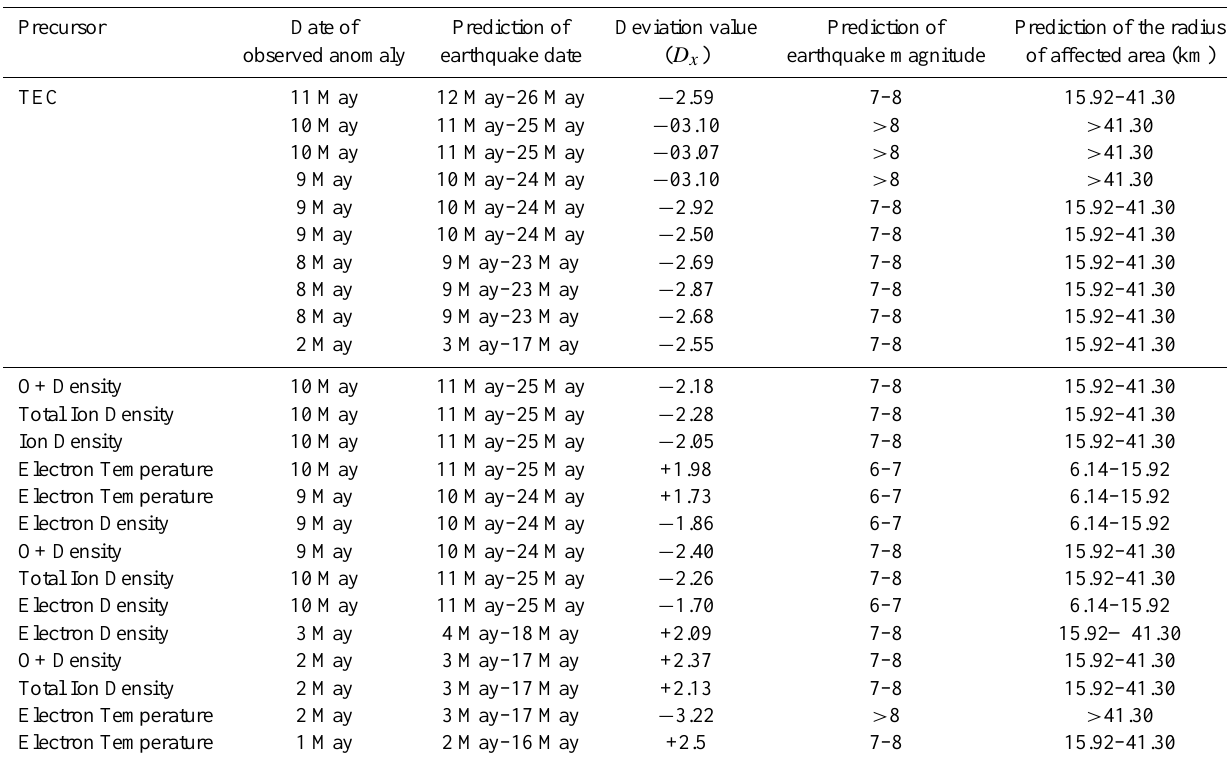
Table 5. Different precursors concerning Sichuan earthquake (Akhoondzadeh,